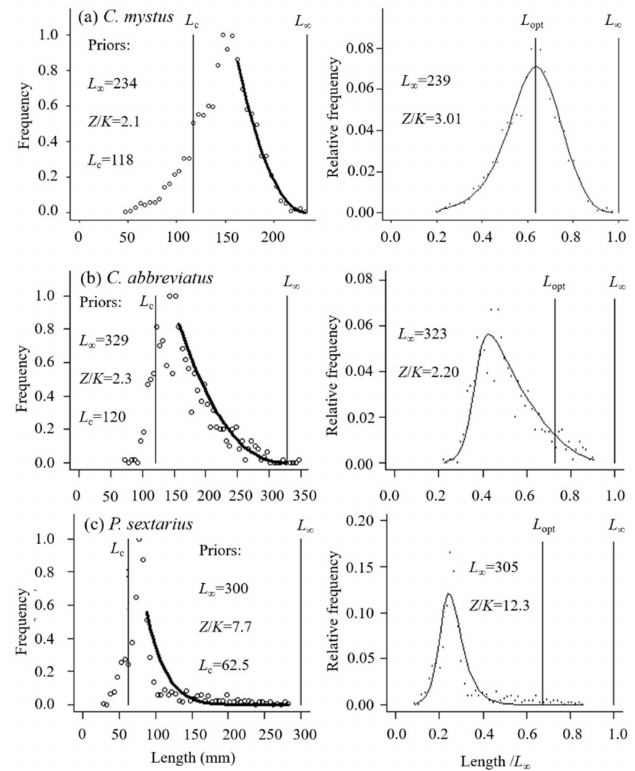
Figure 4. LBB modeling for the surrogate species . L ∞ represents the asymptotic length, L c signifies the length at first capture, L opt represents the length where the unexploited cohort biomass was maximized, and Z / K represents the ratio of total mortality to the somatic growth rate. The relative length frequencies in the left panel were used to estimate the prior values of L ∞ , Z / K , and L c . The curves in the right panel were fitted to the LBB master equation, which provided the information of L opt